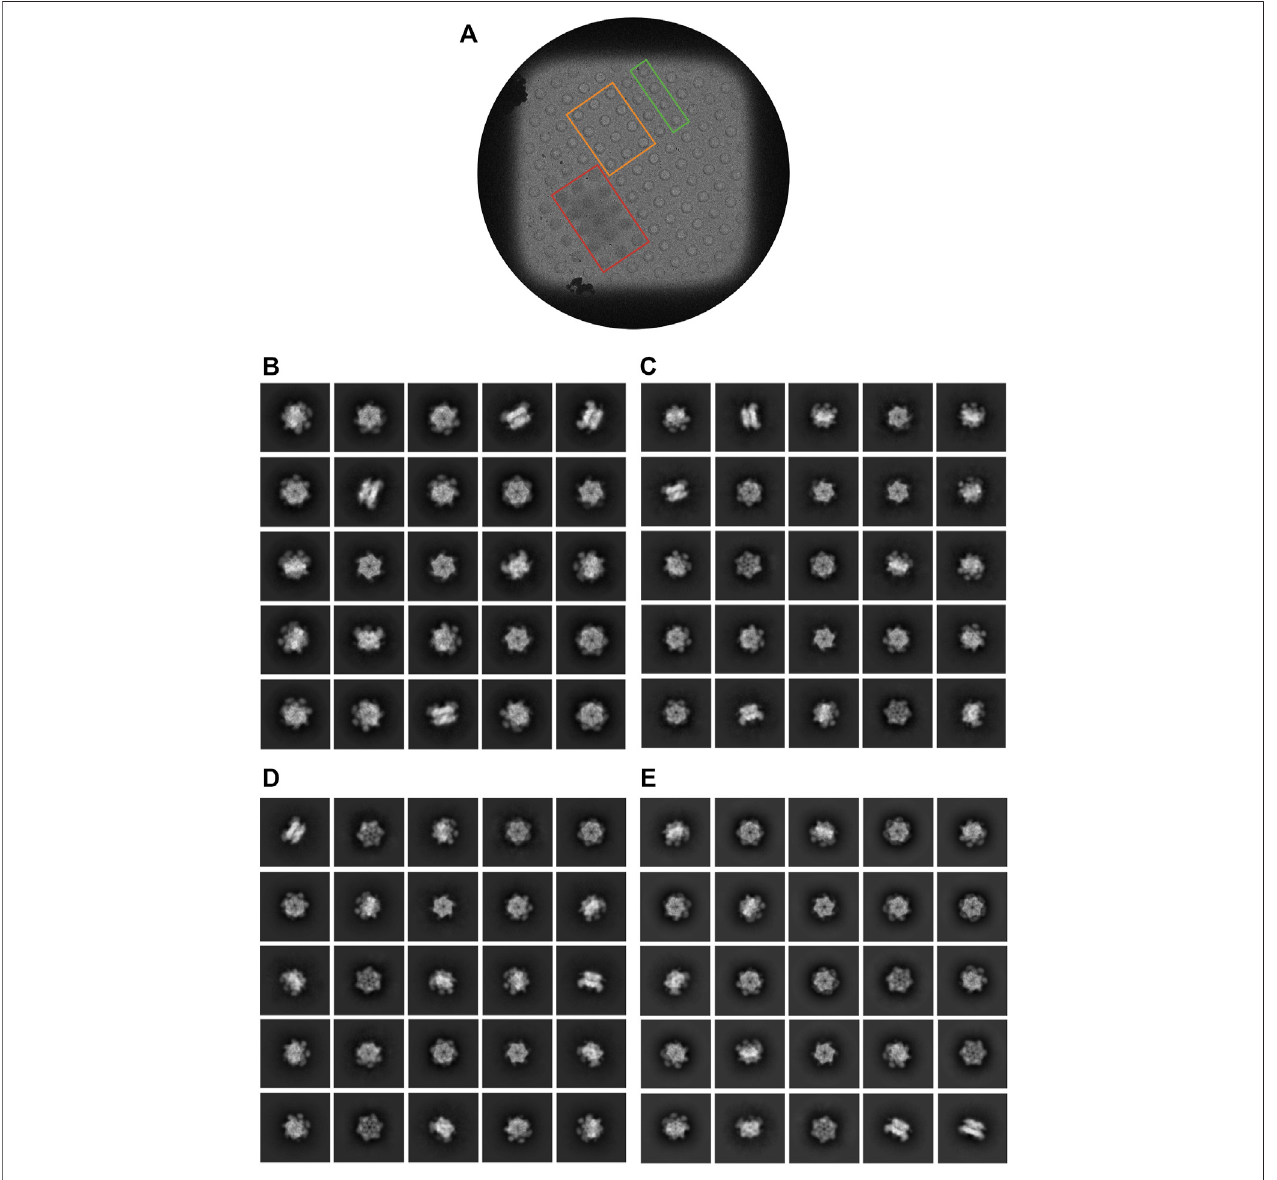
FIGURE 6 | Characterization of cryo-EM data iteratively collected from regions displaying various ice thicknesses. (A) Representative grid square from optimized dataset4.Examples ofholesinwhichtheicewastoothick(red),toothin(orange), orwasapproximatelythedesired thickness(green)forthisdataset areoutlined. (B – E) Representative 2D class averages from the optimized datasets 1, 2, 3, and 4, respectively.